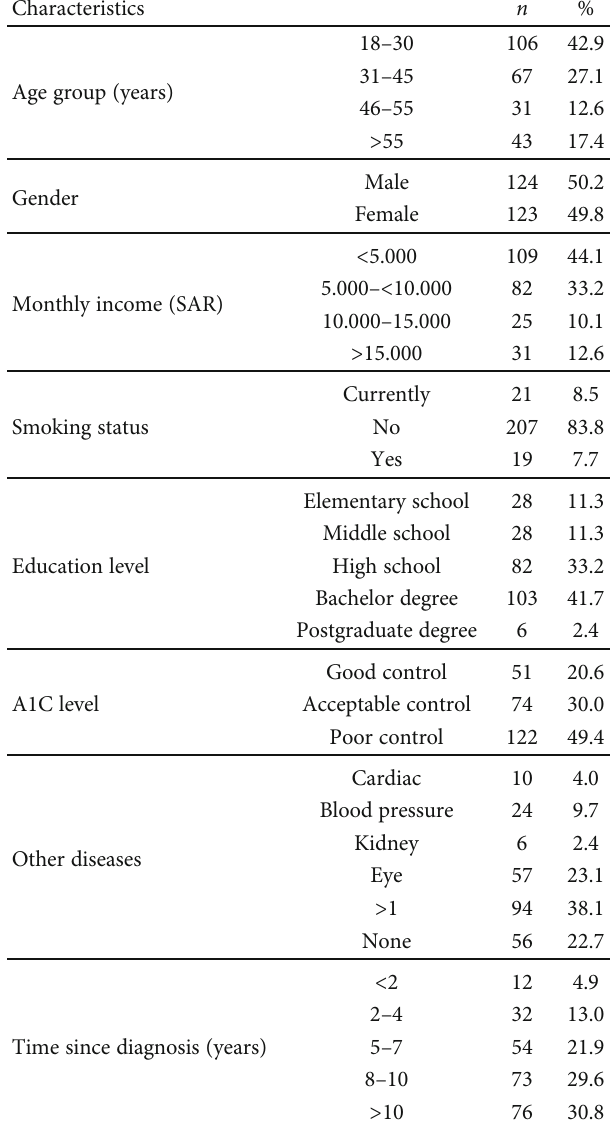
Table 1: Patients ’ demographic characteristics ( n = 247 ).